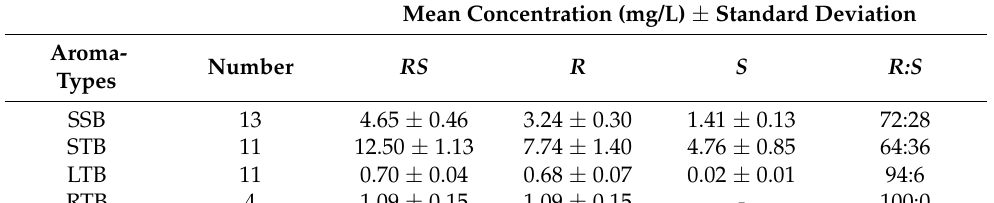
Table 5. Enantiomeric concentrations and distribution of 2-pentanol in four types of Baijiu with LLE. Mean Concentration (mg/L) ± Standard Deviation